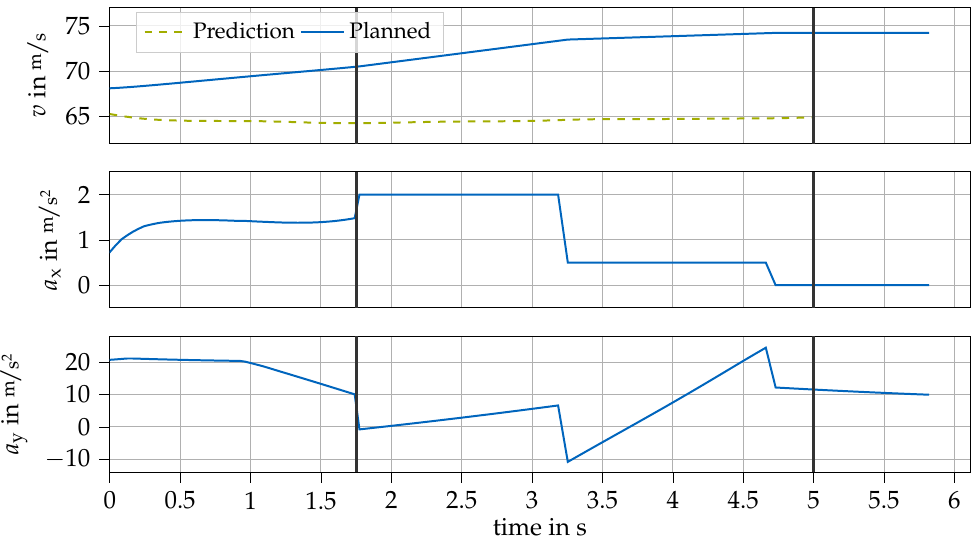
Figure 12. Predicted opponent velocity and planned ego motion for the time step marked in Figure 11. The end of the initial edge and the minimum planning horizon of 5s are indicated by black verti- cal